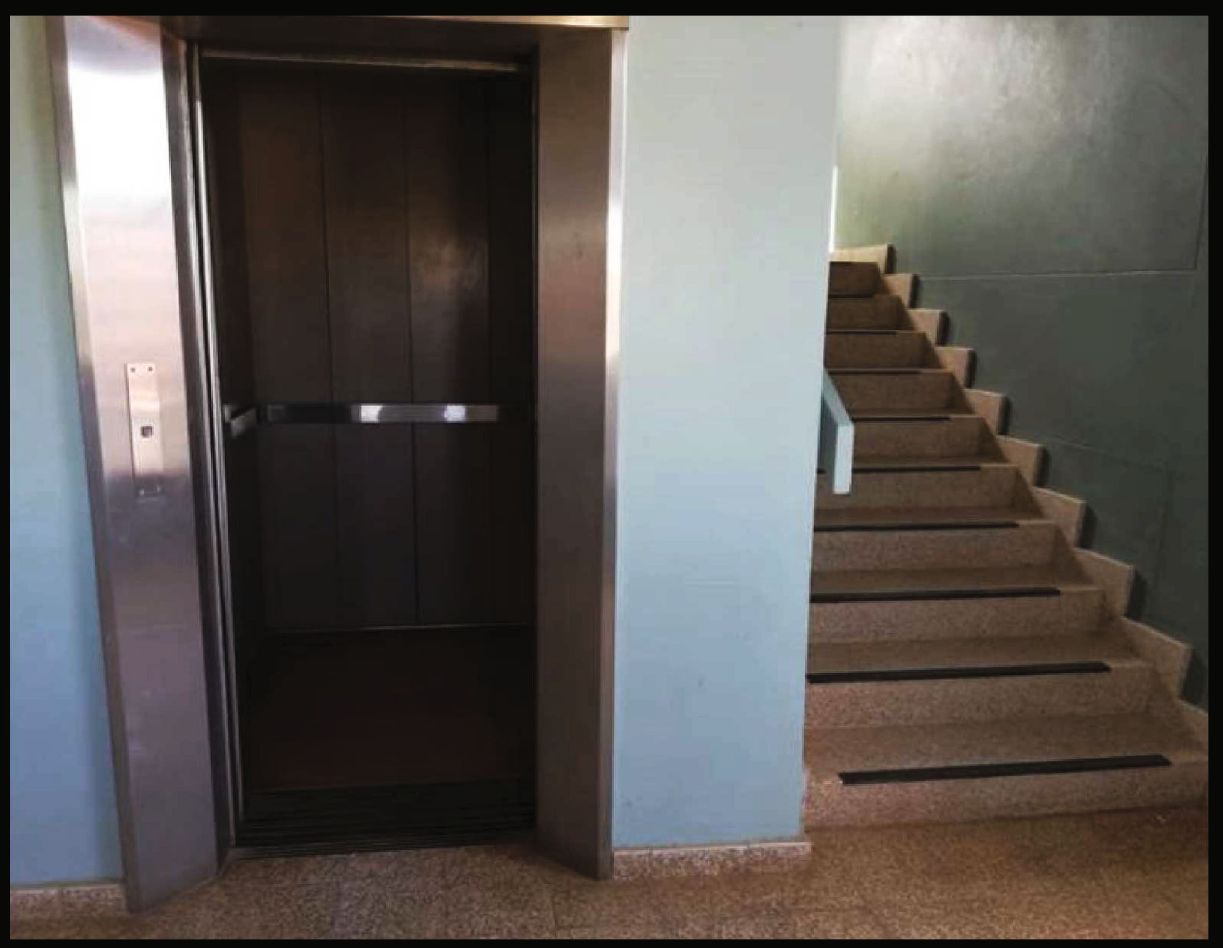
Figure 4: Five-story building accessible through a lift and stairs